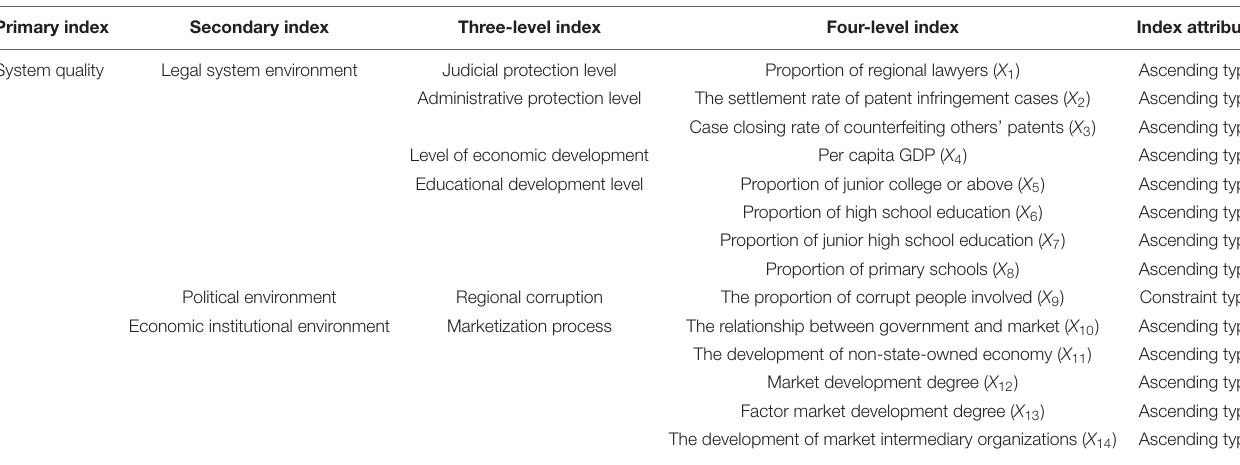
TABLE 1 | Construction of a system quality index